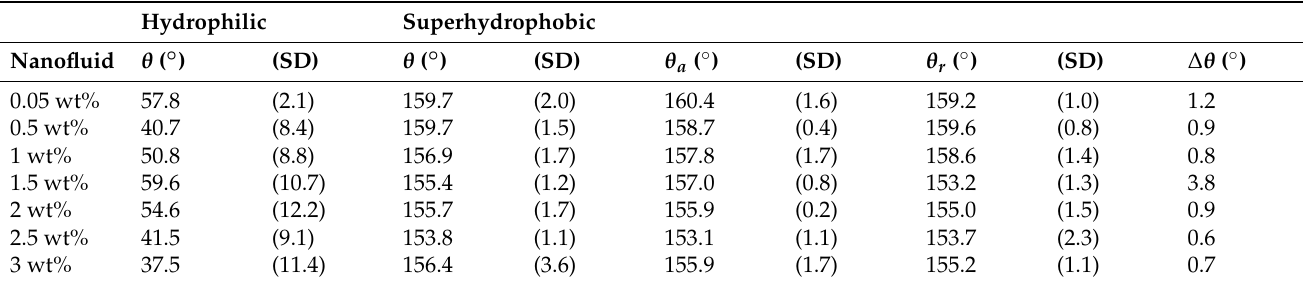
Table 7. Mean contact angles of nanofluids, for the hydrophilic and superhydrophobic regions, after the experimental test, at a temperature of 20 ◦ C.